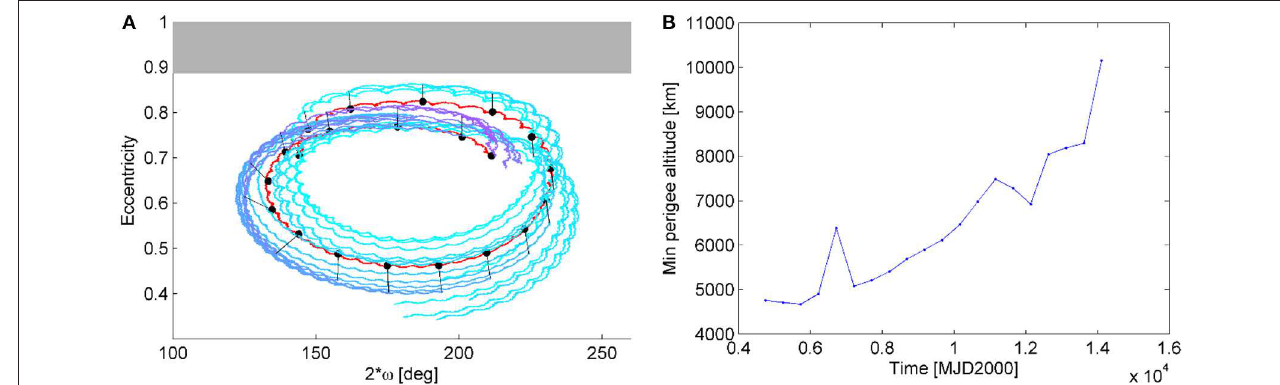
FIGURE 10 | XMM-Newton re-entry disposal. (A) Maneuvers in the eccentricity-2 ω phase space (black points: starting times analyzed for the re-entry disposal). (B) Minimum perigee reached during the orbit long-term evolution for each solution. The initial inclination and the argument of the perigee are measured with respect to the Moon’s